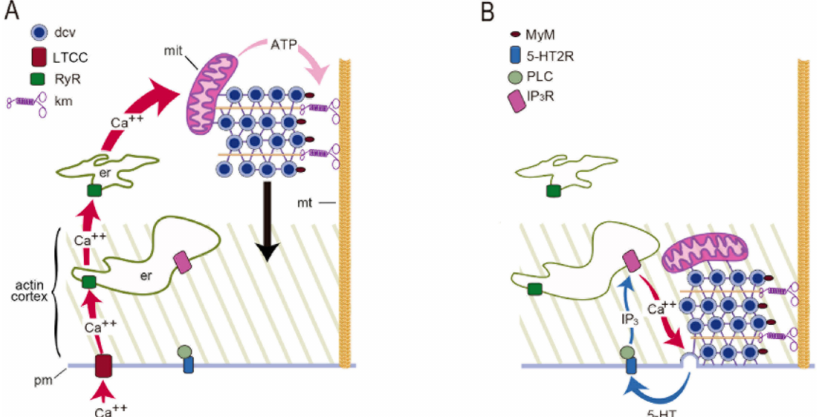
Figure 10. Mechanism for somatic exocytosis of serotonin. ( A ) A train of action potentials produces opening of L-type calcium channels (LTCC). Calcium entry activates ryanodine receptors (RyR) in endoplasmic reticulum (er) to produce calcium-induced calcium release. The amplified calcium wave invades the soma. In the mitochondria (mit) calcium stimulates ATP synthesis. ATP activates kinesin motors (km) that transport dense core vesicles (dcv) along microtubules (mt). The black arrow indicates the vesicle transport. ( B ) As vesicles enter the actin cortex, myosin motors (MyM) couple to actin and contribute to transport. Release is maintained by a positive feedback loop. Serotonin that is released activates 5-HT2 receptors (5-HT2R). Activation of phospholipase C (PLC) produces IP3, which binds to receptors (IP3R) to activate intracellular calcium release. Such calcium maintains exocytosis going on until last vesicles fuse. Obtained with permission from